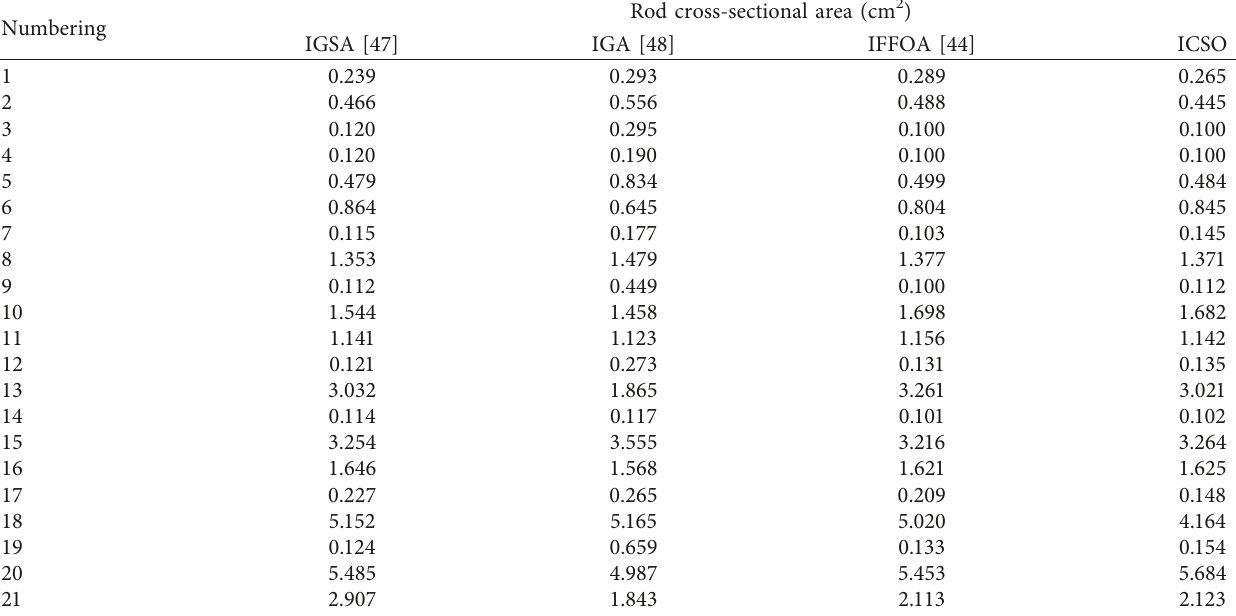
Table 13: Comparison of optimization results of the 200bar plane truss